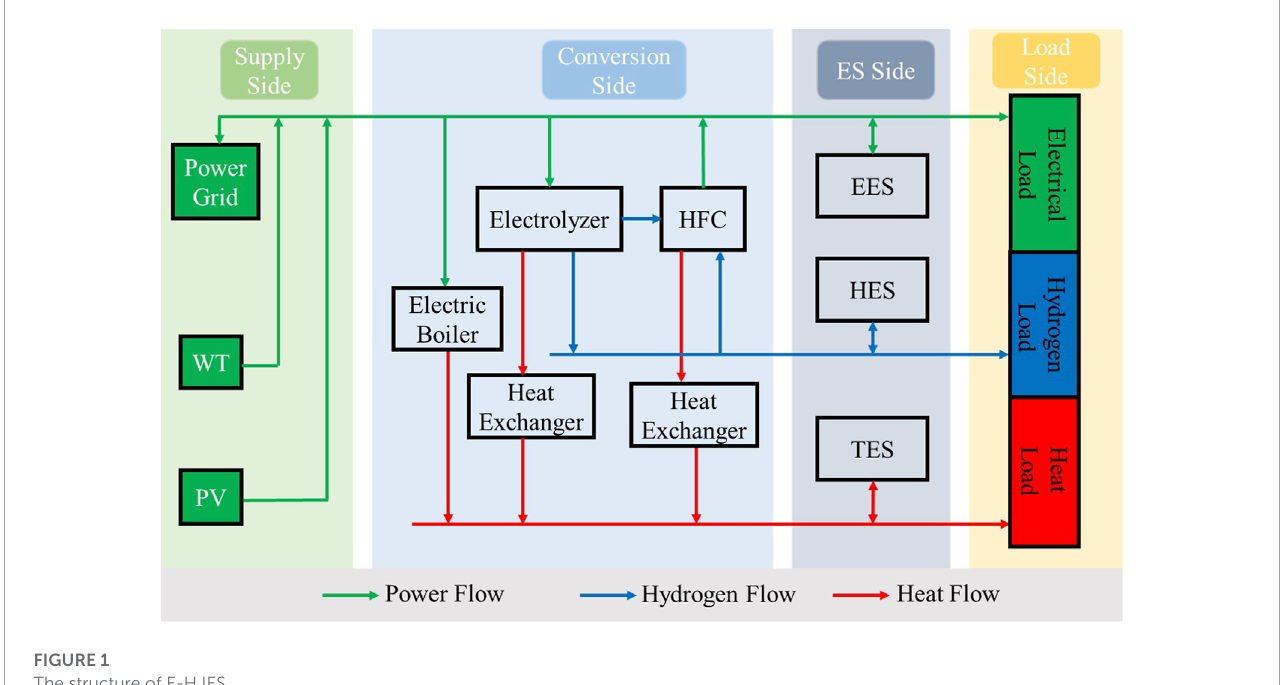
FIGURE 1 The structure of E-H IES.